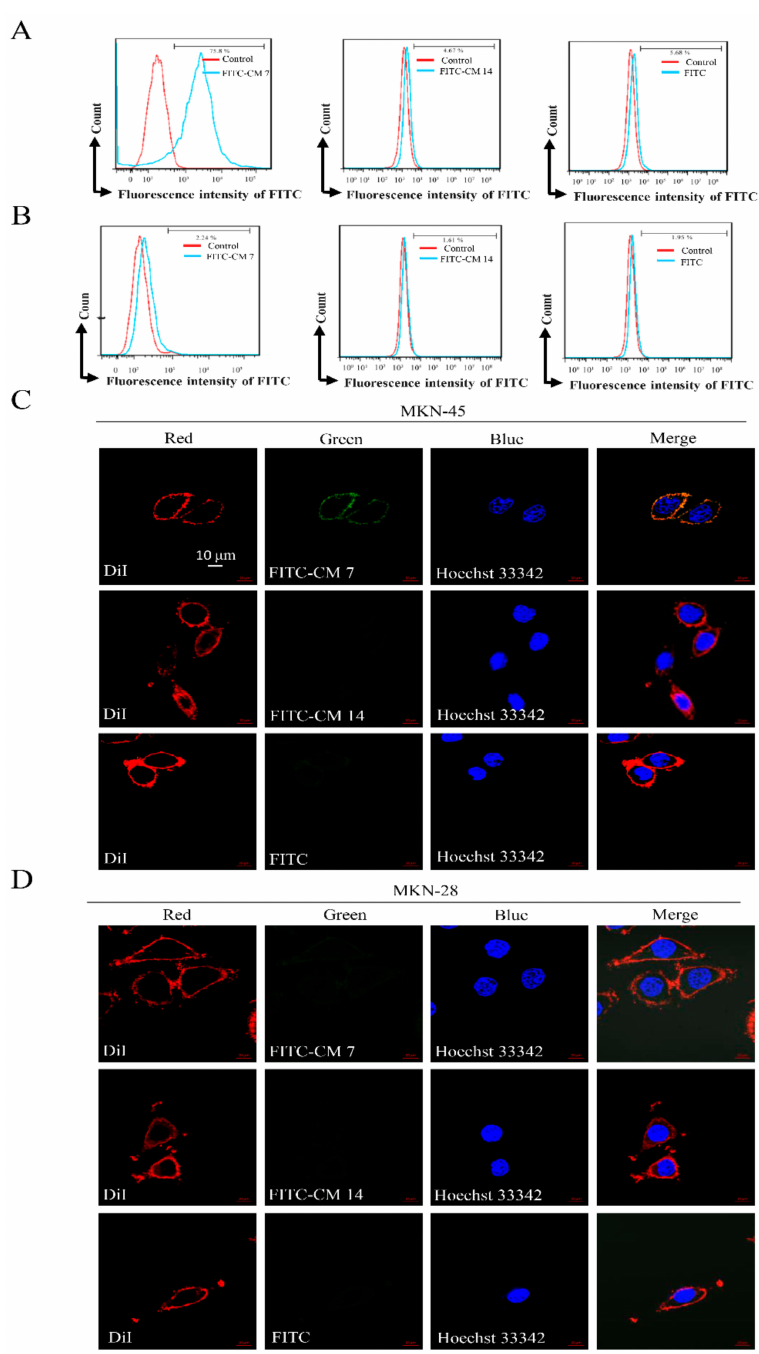
Figure 4. CM 7 binds preferentially to c-Met-enriched cells. ( A ) The binding ability of peptides FITC-CM 7, FITC-CM 14, or FITC alone and MKN-45 cells expressing c-Met was detected by flow cytometry after incubation with 1 µ M FITC-CM 7, FITC-CM 14, or FITC, respectively. ( B ) The binding ability of peptides FITC-CM 7, FITC-CM 14, or FITC alone and c-Met-negative-cell MKN-28 was detected by flow cytometry after incubation with 1 µ M FITC-CM 7, FITC-CM 14, or FITC, respectively. ( C ) In vitro fluorescence imaging of c-Met under optimal conditions (1 µ M, 1 h) showed high levels of fluorescent signals in the MKN-45 cells incubated with FITC-CM 7 compared with the MKN-45 cells incubated with FITC-CM 14 or FITC alone. ( D ) In vitro fluorescence imaging of c-Met under optimal conditions (1 µ M, 1 h) did not show any fluorescent signals in MKN-28 cells incubated with FITC-CM 7, FITC-CM 14, or FITC alone. Scale bar = 10 µ